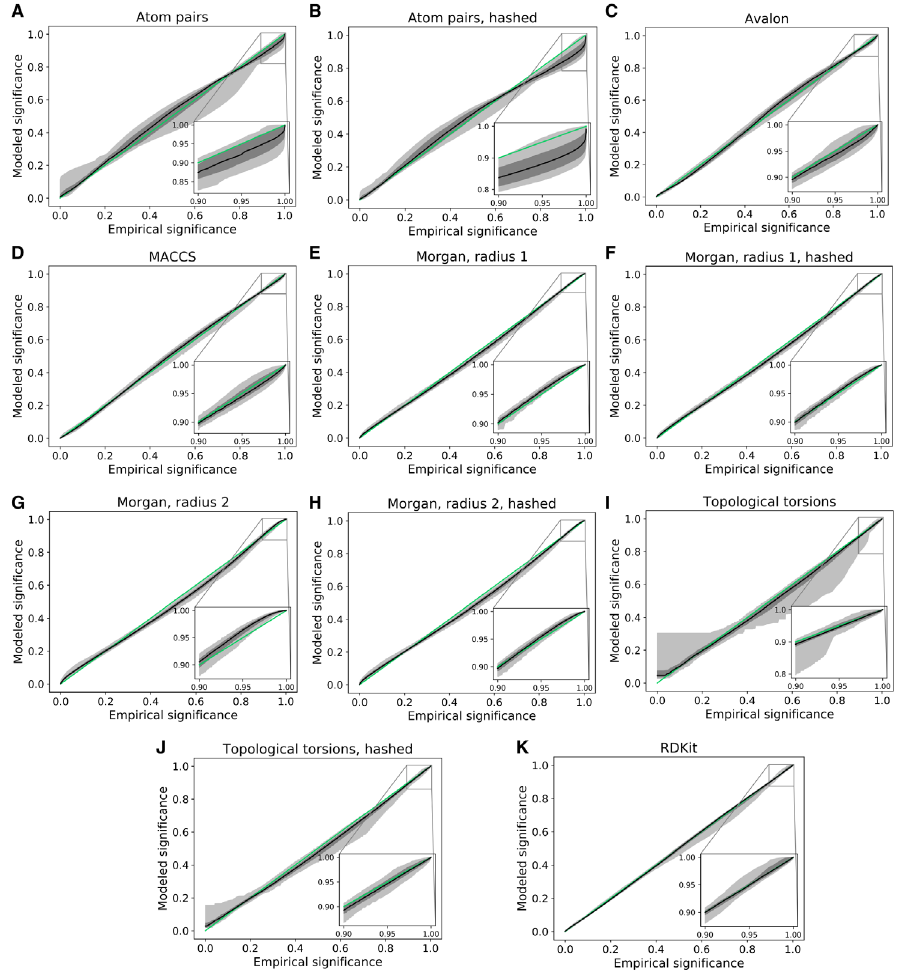
Figure 2. Empirical versus modeled significance values. For the fingerprints in Table 1, each of the graphs ( a ) – ( k ) shows the variation of correspondences between empirical and modeled significance values of 100 conditional distributions obtained by selecting random reference compounds. Empirical distributions for each reference compound were determined from comparisons of 100,000 randomly chosen compounds. The black line indicates the median correspondence between empirical and modeled distribution. The dark gray area shows the interquartile range and the light gray area the range from the 5 th to the 95 th percentile. The green line is the diagonal corresponding to a perfectly matching model. The inserts highlight correspondences for significance values larger than